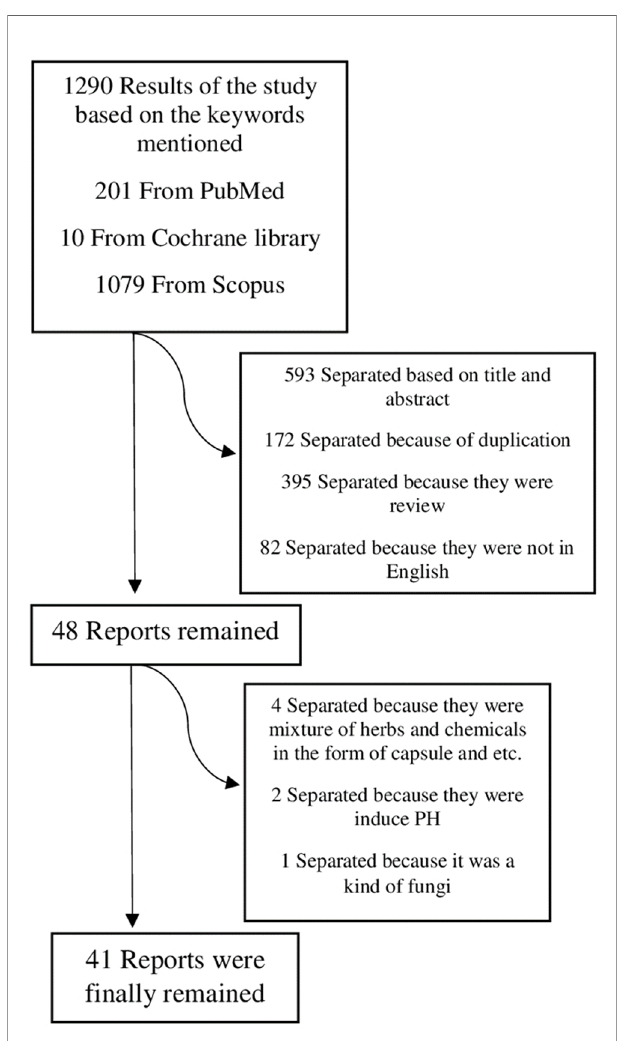
FIGURE 1 | Study design and